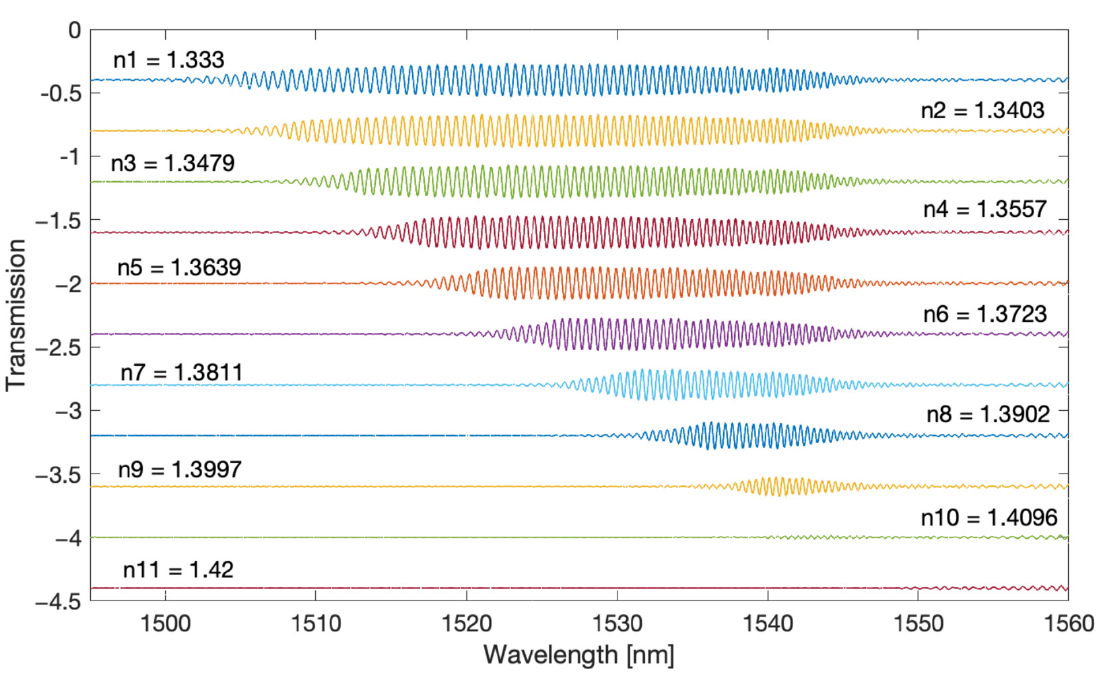
Figure 4. TFBG spectra after Fourier filtering for the first (main) frequency band.